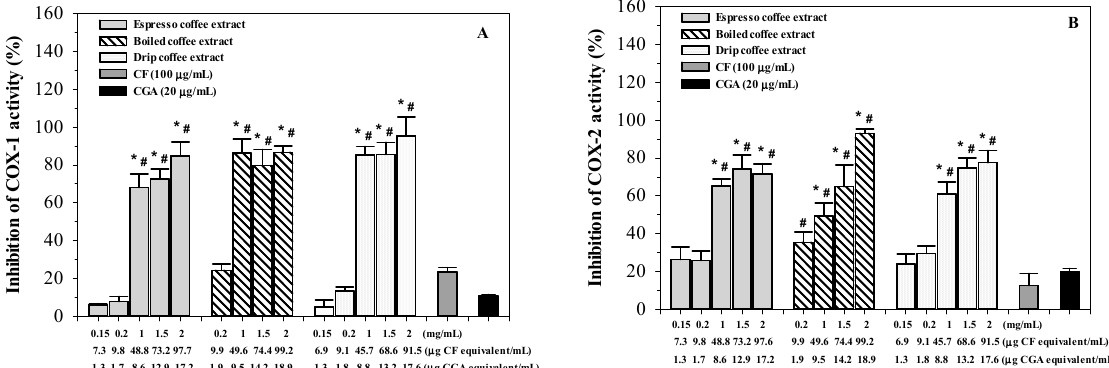
Figure 8. Inhibitory effects of espresso, boiled and drip coffee extracts (0.15–2 mg/mL each), caffeine 100 µ g/mL) and chlorogenic acid (CGA, 20 µ g/mL) on cyclooxygenase 1 (COX-1) ( A ) and cyclooxygenase 2 (COX-2) ( B ) activities. Data obtained from five separate duplicate measurements are expressed as mean ± SEM values. * p < 0.05 when compared with the CGA; # p < 0.05 when compared to the CF.